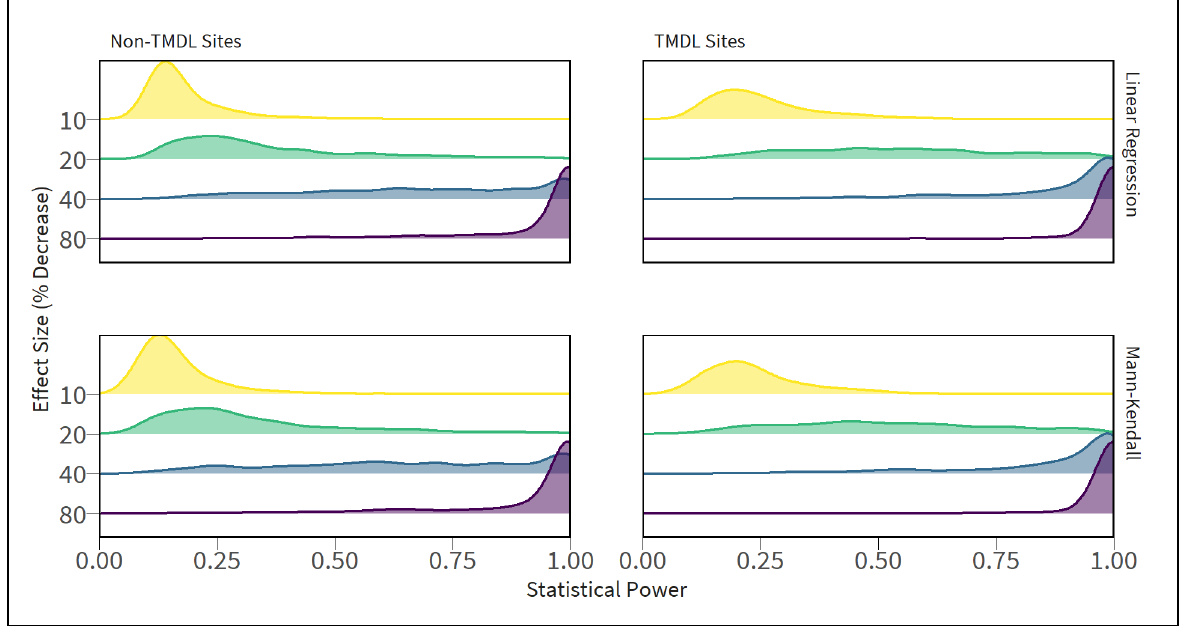
Figure 4. Scaled density plots of Mann-Kendall and linear regression statistical power distribution for TMDL and non- TMDL SWQM sites as a function of effect size at ɑ = 0.1. Individual curves represent the scaled density estimate of statistical power values calculated for SWQM sites at a given effect size (y-axis values).